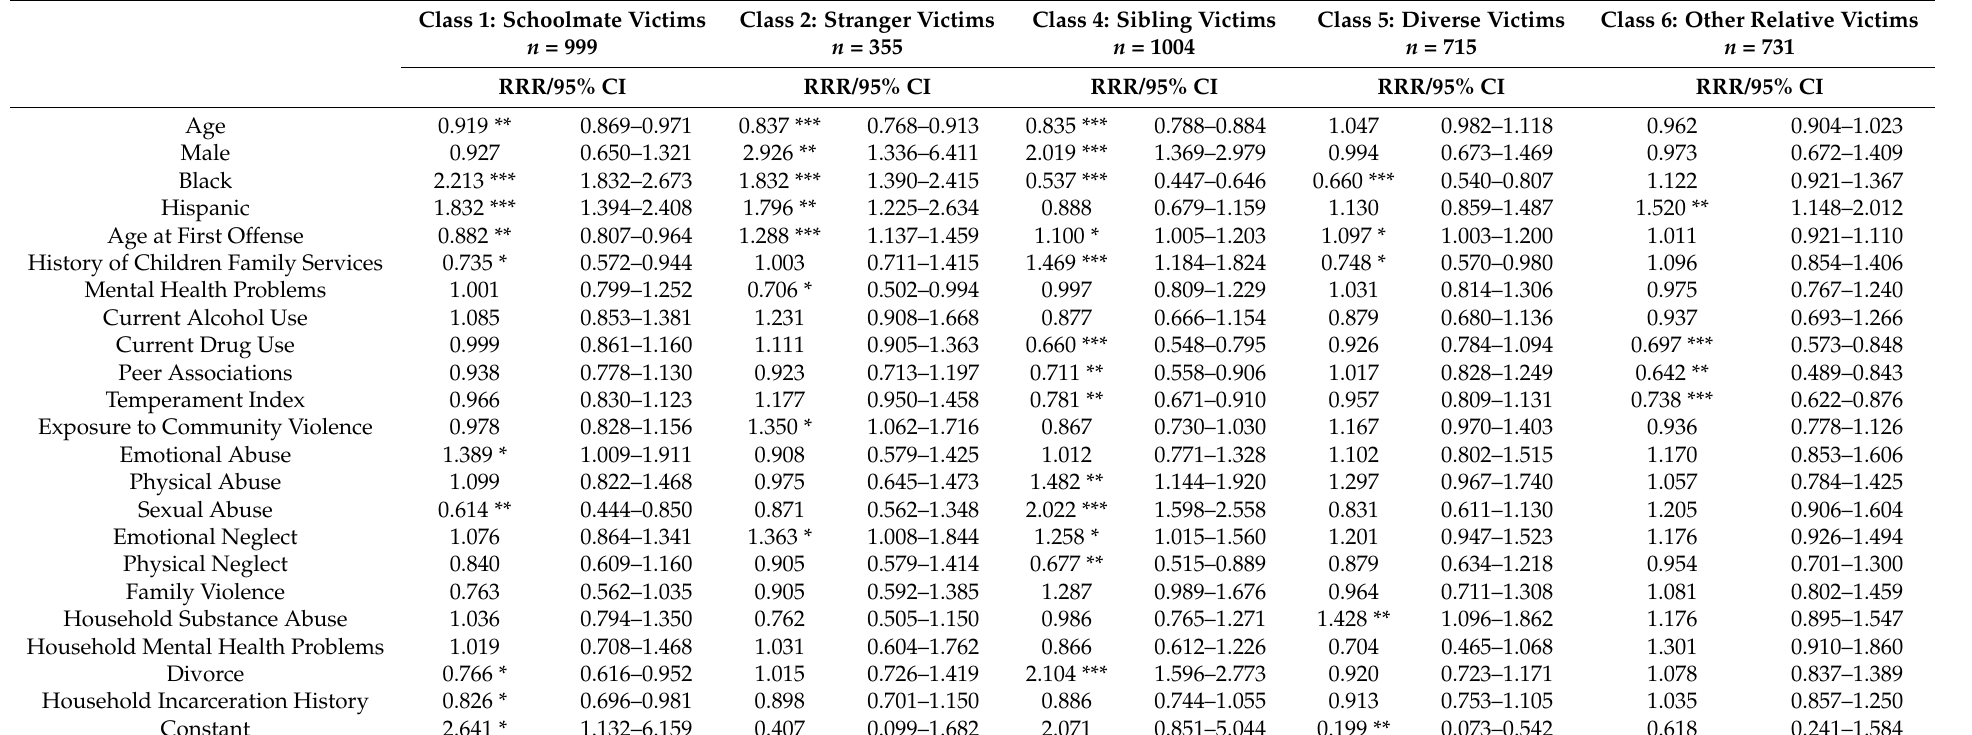
Table 4. Multinomial logistic regression predicting class